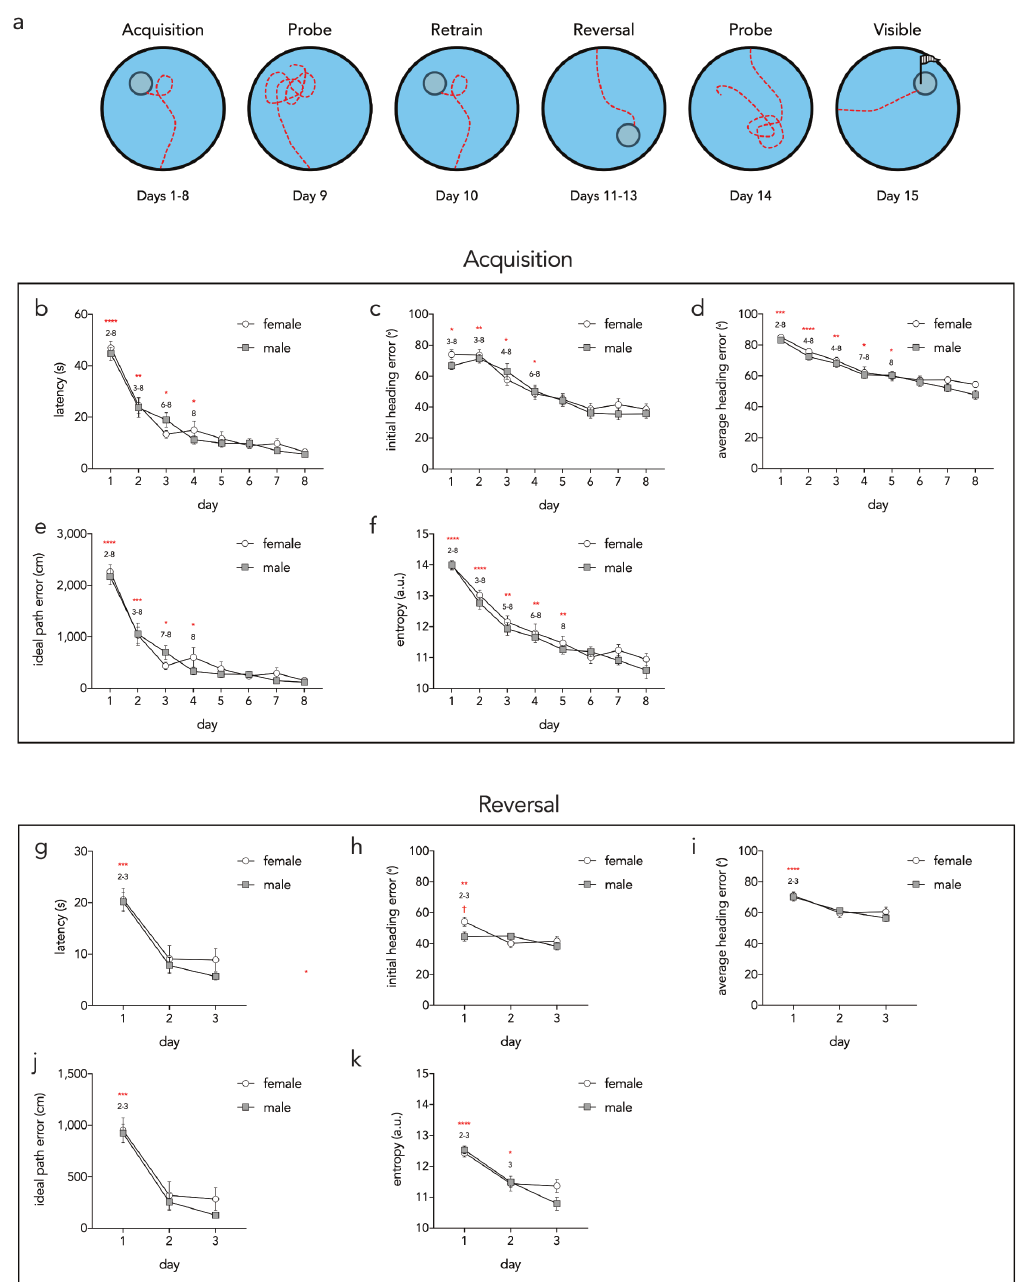
Figure 3. Acquisition and reversal performance as assessed by individual parameters. a ) Schematic outline of full behavioral paradigm. Individual performance metrics were analyzed for acquisition ( b – f ) and reversal ( g – k ) stages of testing. b ) Latency to reach the platform decreased across days (day effect F =75, P<0.0001; sex effect F =0.3, P=0.6; interaction F =0.9, P=0.5). Asterisks denote statistically 7,231 1,33 7,231 significant differences from the subsequent days that are indicated by the numbers. c ) Initial heading error decreased over days (day effect F =39, P<0.0001; sex effect F =0.4, P=0.6; interaction F =0.7, P=0.6). d ) Average heading error decreased over days (day effect 7,231 1,33 7,231 F =48, P<0.0001; sex effect F =2.5, P=0.12; interaction F =0.6, P=0.8). e ) Idea path error decreased over days (day effect F =79, 7,231 1,33 7,231 7,231 P<0.0001; sex effect F =0.3, P=0.6; interaction F =1.0, P=0.4). f ) Entropy decreased over days (day effect F =75, P<0.0001; sex effect 1,33 7,231 7,231 F =1.3, P=0.3; interaction F =0.5, P=0.8). g ) Latency decreased over days (day effect F =69, P<0.0001; sex effect F =0.5, P=0.5; 1,33 7,231 2,66 1,33 interaction F =0.7, P=0.5). h ) Initial heading error decreased over days and was greater in females on day 1 (day effect F =9, P<0.001; 2,66 2,66 sex effect F =1.0, P=0.3; interaction F =4.7, P=0.01). i ) Average heading error decreased over days (day effect F =21, P<0.0001; 1,33 2,66 2,66 sex effect F =0.2, P=0.7; interaction F =0.9, P=0.4). j ) Ideal path error decreased over days (day effect F =98, P<0.0001; sex effect 1,33 2,66 2,66 F =0.5, P=0.5; interaction F =0.7, P=0.5). k ) Entropy decreased over days (day effect F =39, P<0.0001; sex effect F =0.6, P=0.4; 1,33 2,66 2,66 1,33 interaction F =2.6, P=0.08). *P<0.05, **P<0.01, ***P<0.001, ****P<0.0001, † P<0.05 within day, male vs female comparison. Symbols = mean 2,66 ± standard